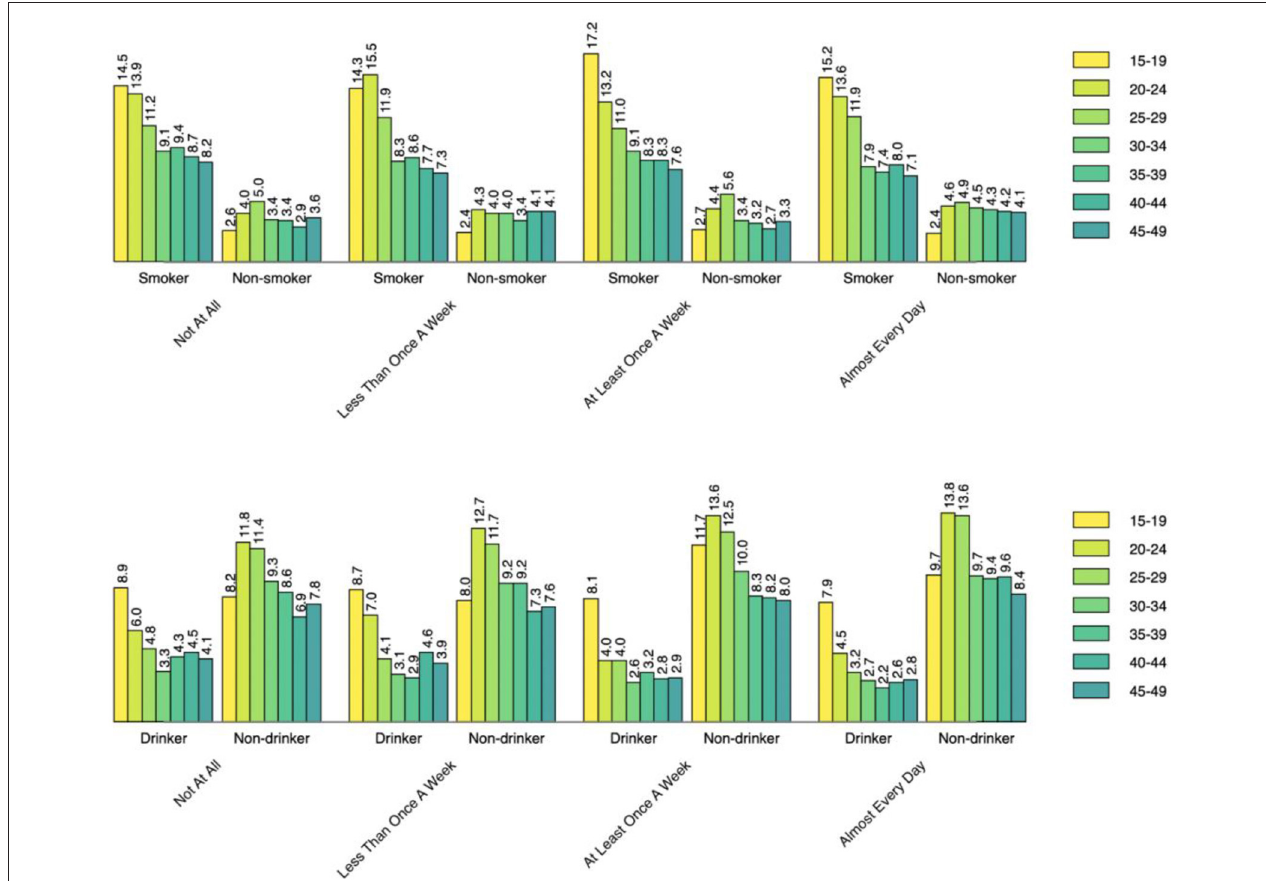
FIGURE 2 | Smoking status across the age groups by TV watching